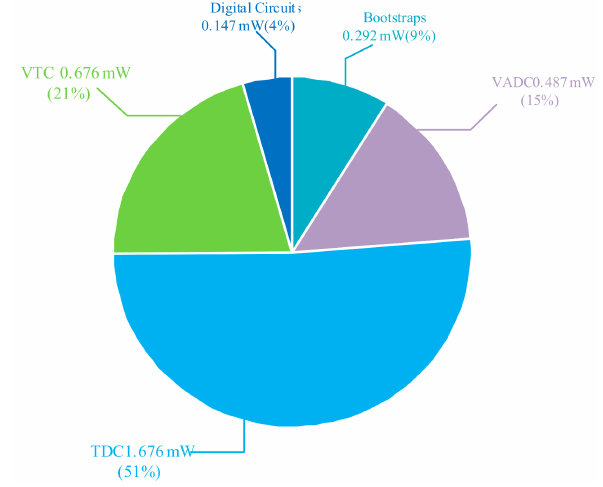
Figure 8. Pie chart of the ADC power distribution.